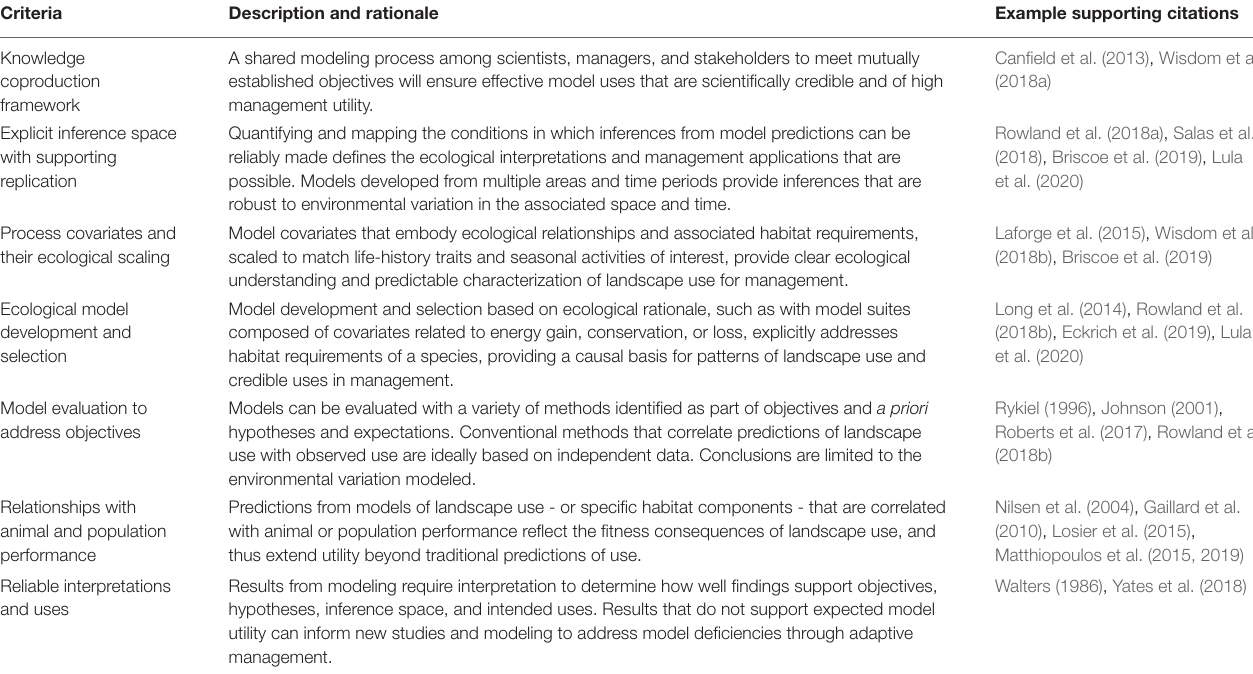
TABLE 1 | Criteria to frame and guide the design, development, utility of landscape-use models for ungulates, and associated description and rationale with example supporting